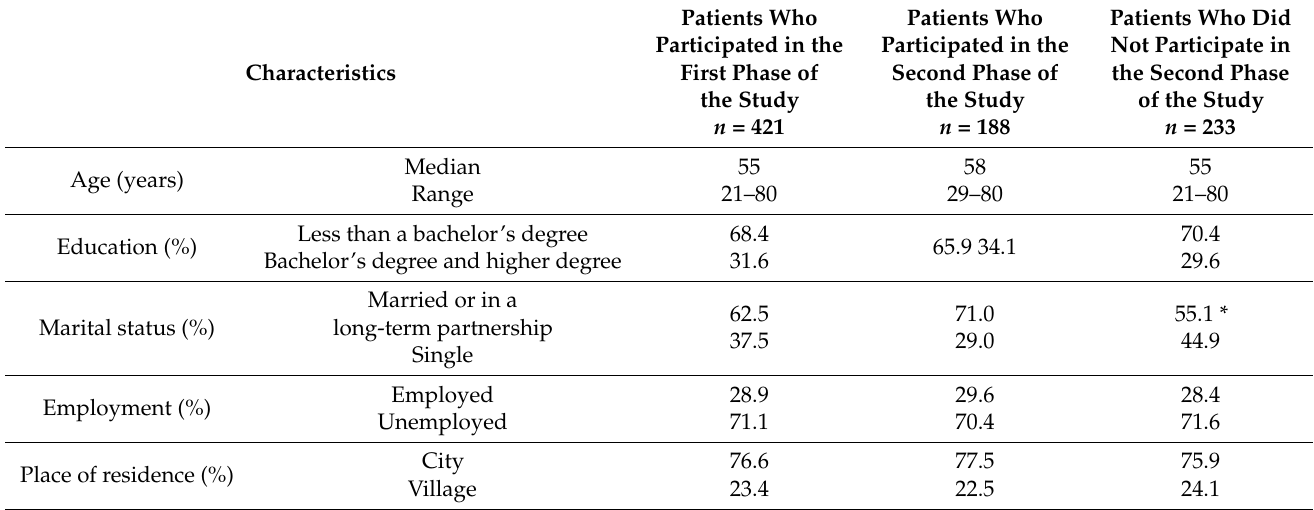
Table 1. Sociodemographic characteristics of patients ( n =